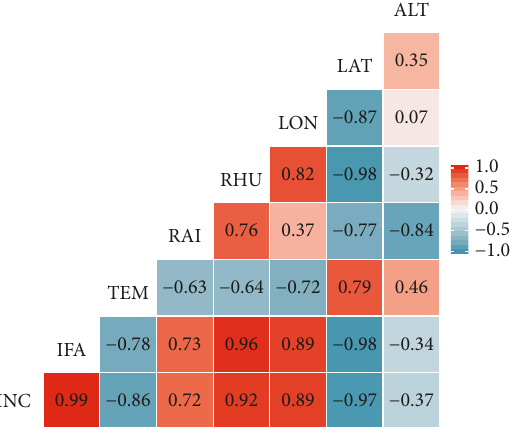
Figure 8: Correlation between climatic, geographic, and downy mildew incidence. INC: incidence, IFA: infected area, TEM: temperature, RAI: rainfall, RHU: relative humidity, LON: longitude, LAT: latitude, and ALT: altitude.